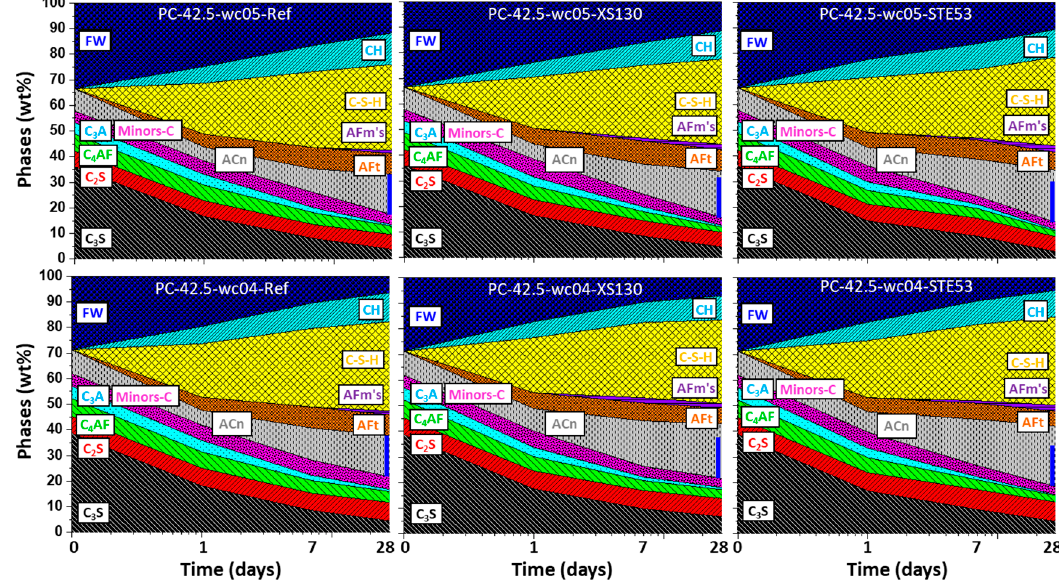
Figure 4. Phase development for PC-42.5 pastes based on the RQPA results: ( top ) w / c = 0.50, ( bottom ) w / c = 0.40. The total amorphous content determined by the internal standard methodology has been divided into three components: calculated free water, C-S-H content, and ACn, as described in the Supplementary Information; these amounts are obtained taking into account the chemical hydration reactions. ACn accounts for any other amorphous phases, i.e., iron siliceous hydrogarnet, AFm-type phases, and the amorphous content within the unreacted clinker phases. The blue vertical lines highlight the amount of ACn at 28 days in the two pastes without admixtures. The seeded pastes have significantly higher amounts of amorphous phases; see the blue lines. Minors-C stands for all minor phases in the pristine cement.